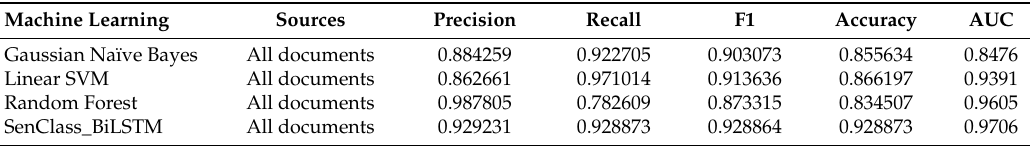
Table 6. Comparison of SenClass and the three baseline methods based on the precision, recall, F1, accuracy, and AUC measurements.